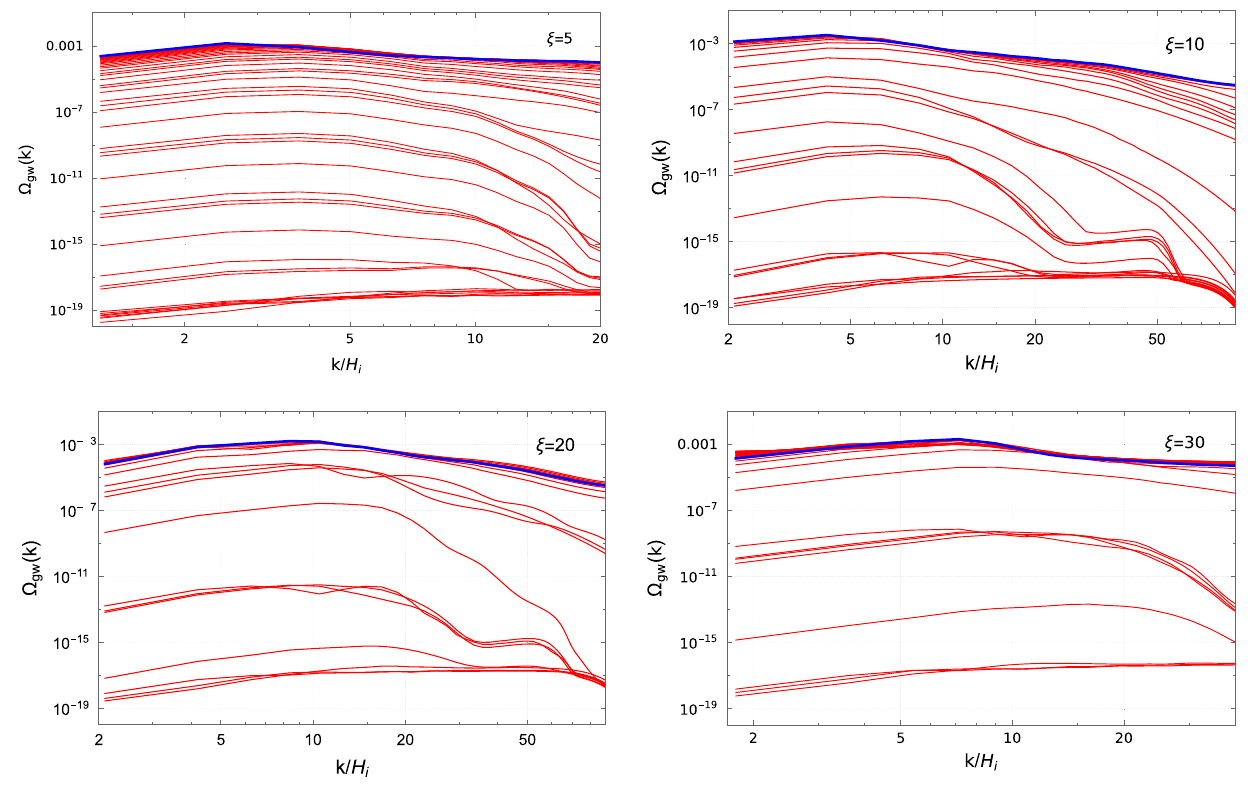
Fig. 2 The evolutions of the density spectra of GWs as a function of k / H i with time t for ξ > 0. The spectra from bottom to up are plotted with the time interval (cid:14) t = 0 . 0625 H − 1 , with Blue line corresponding to the final i